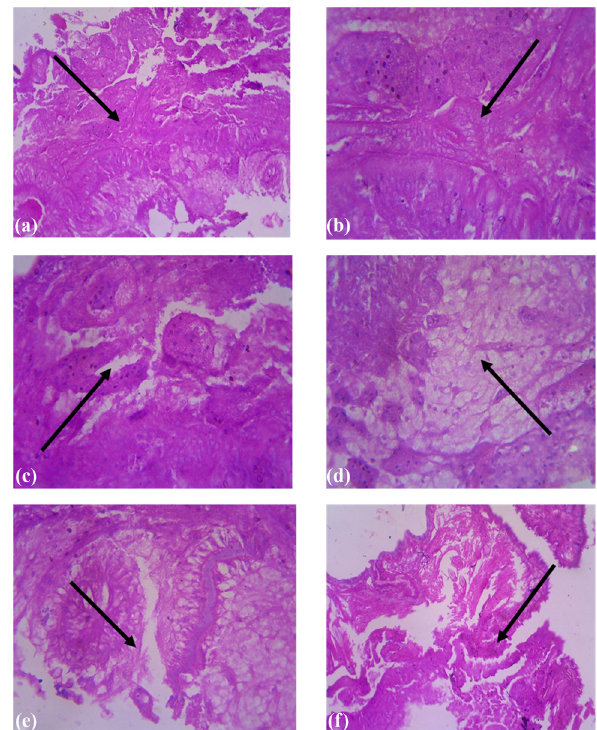
Figure 4: Histopathology of P. posthuma treated upon D. viscosa : ( a ) physiology of P. posthuma treated upon aqueous extract of D. viscosa ; ( b ) treatment of ethanolic extract of D. viscosa ; ( c ) treatment of methanolic extract of D. viscosa ; ( d ) treatment of chloroform; ( e ) treatment upon petro benzene extract of D. viscosa ; and ( f ) treatment of albendazole standard drug shows the entire physiology of P. posthuma was collapsed by the